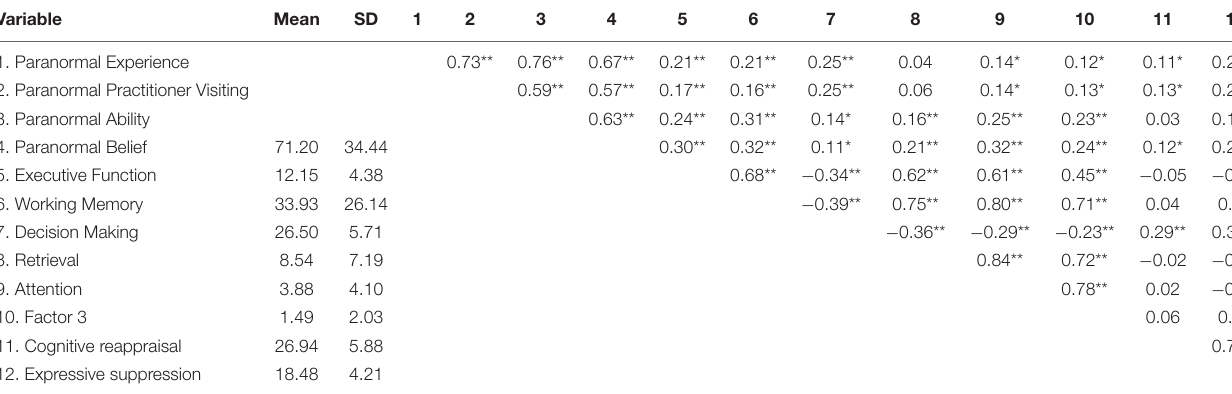
TABLE 1 | Descriptive statistics and correlations among variables. Variable